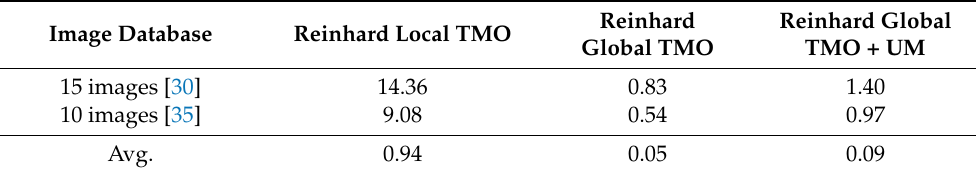
Figure 2. Comparison of before and after unsharp masking. ( a ) Modified Reinhard TMO; ( b ) modified Reinhard TMO + unsharp masking. Table 1. Comparison of execution times of Reinhard TMOs without and with UM (unsharp masking) (unit: sec).